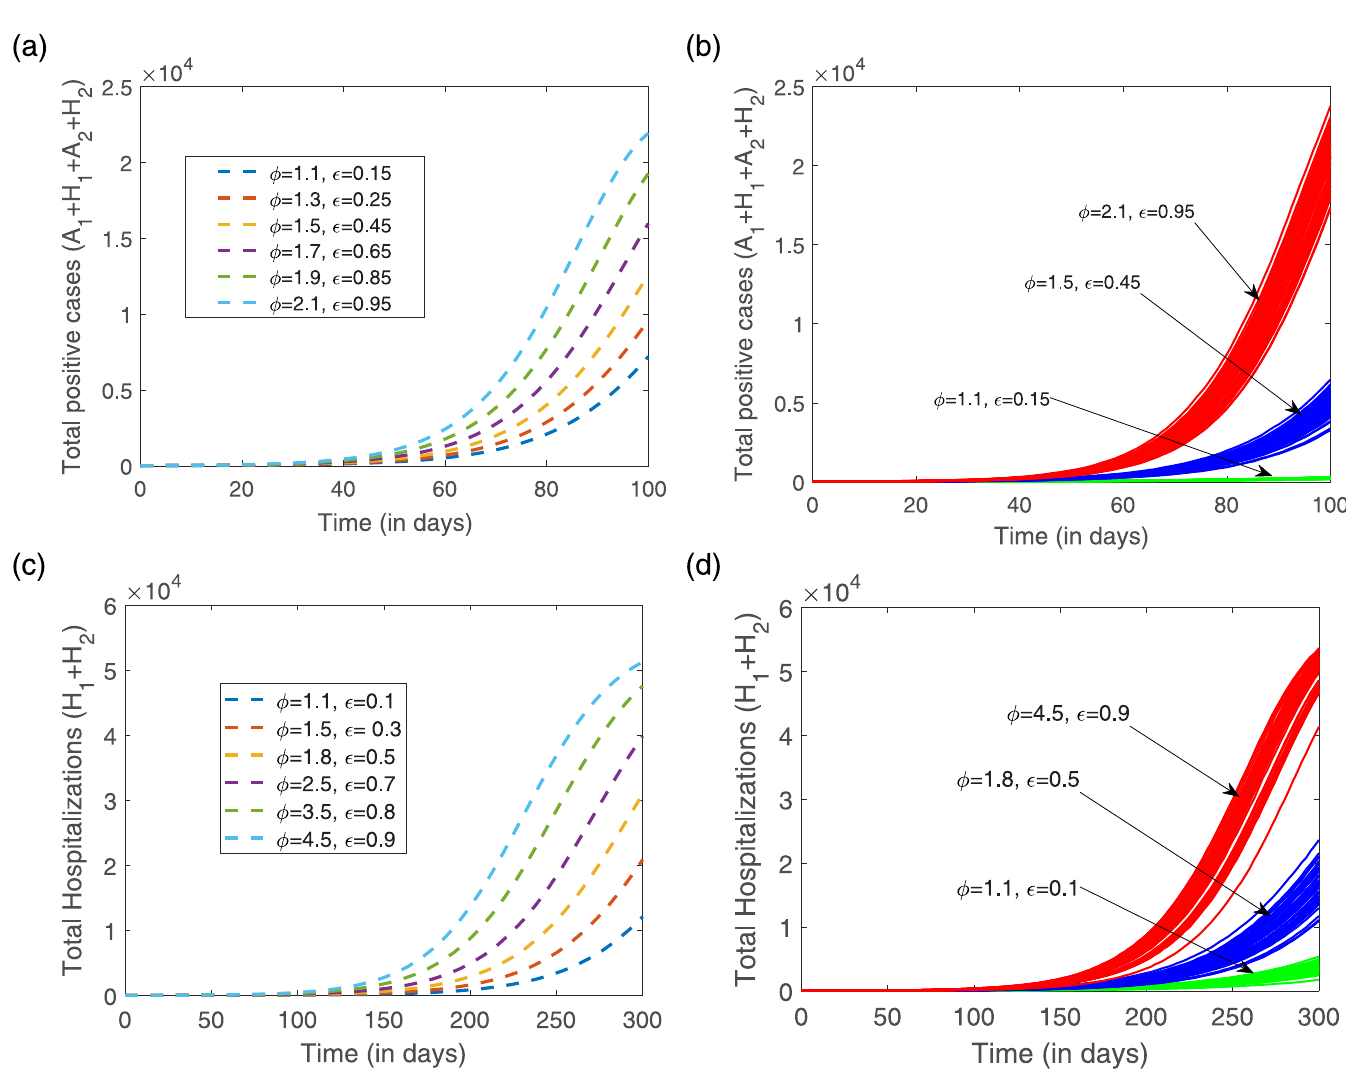
Fig 11. By varying the infectivity scaling factors ϕ and � , the dynamics of the overall disease cases ( A 1 + H 1 + A 2 + H 2 ), and the dynamics of the overall hospitalization ( H 1 + H 2 ) are plotted for 100 and 300 days respectively, using the following parameter set: β = 0.15, δ 1 = 0.003, δ 2 = 0.04, η 1 = 0.035, η 2 = 0.03, α 1 = 0.02, α 2 = 0.01, α 3 = 0.05, α 4 = 0.03 and a = 0.02. In (a) and (c) the deterministic model simulations and in (b) and (d) 100 stochastic